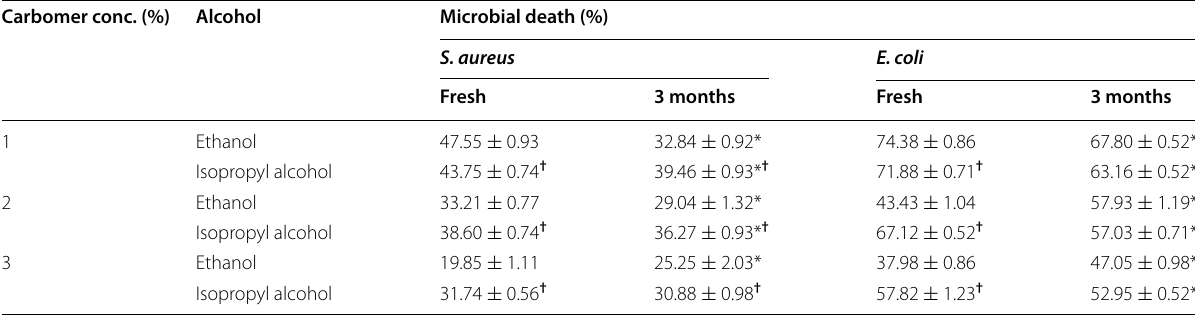
Values represent means SD. Values with * indicate a significant difference ( P < 0.05) from fresh sample for the same alcohol/carbomer/organism. Values with † ± indicate a significant difference ( P < 0.05) from ethanol for the same test time/carbomer/organism. N